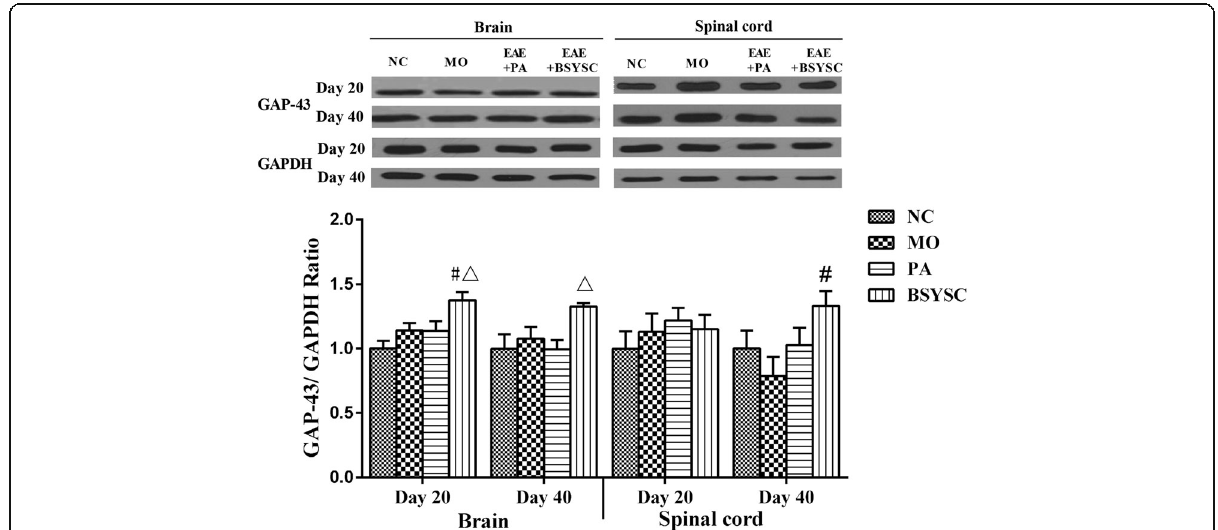
Fig. 3 GAP-43 protein expression in the brain and spinal cord of mice treated with or without BSYSC 20 and 40 dpi. A significant increase in GAP-43 protein was found in the brain 20 dpi and in the spinal cord 40 dpi in BSYSC group. The protein level of GAP-43 was measured by Western blot and quantified using GAPDH as the loading controls. Data are expressed as means ± SE, n = 5 for each group. # p < 0.05 vs. MO; △ p < 0.05 vs.